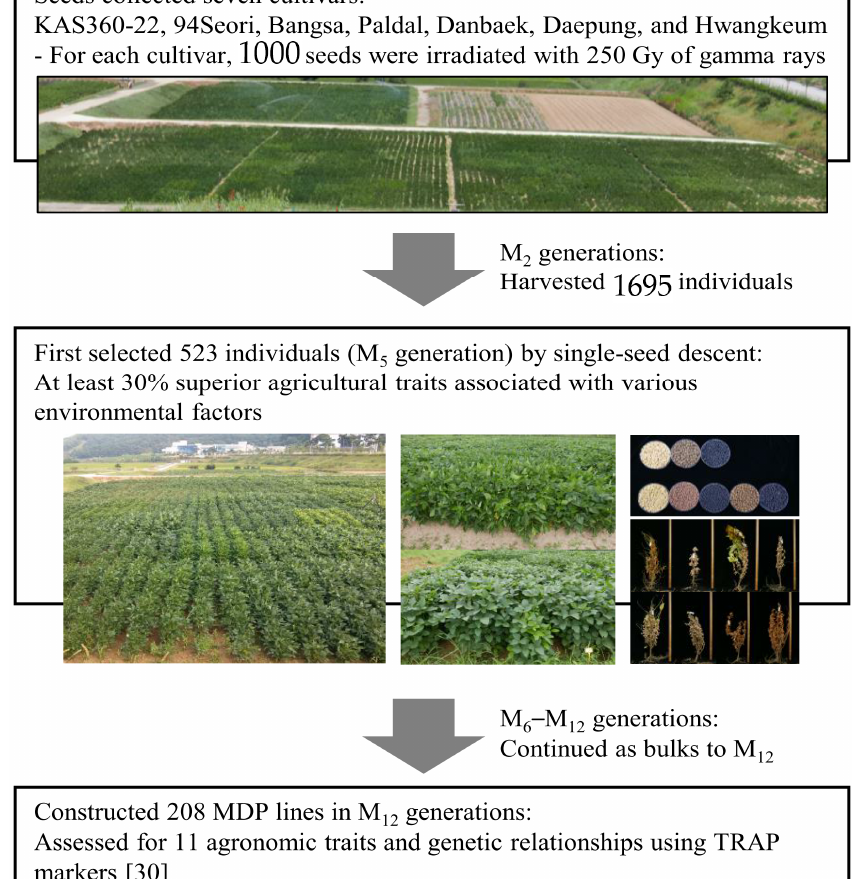
Figure 6. Schematic representation of the development of the 208 MDP lines. In total, 1000 irradiated seeds of each of seven soybean cultivars were sown in a research field of KAERI. Seeds from the 1695 M 2 plants were harvested and first selected for 523 mutant lines in the M 5 generation based on agricultural traits such as grain yield, growth type, and climate adaptability. In a second selection phase in the M 12 generation, 208 genetically fixed mutants were selected to eliminate redundant phenotypes from the 523 mutant lines (additional information is described in